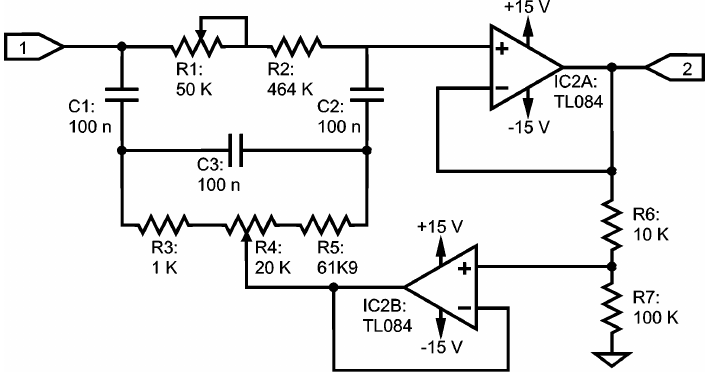
Figure 5. Trimmable bootstrapped twin-T as a notch filter for 50 Hz or 60 Hz; label #1 denotes input from the IA stage and label #2, output to the high-pass filter.